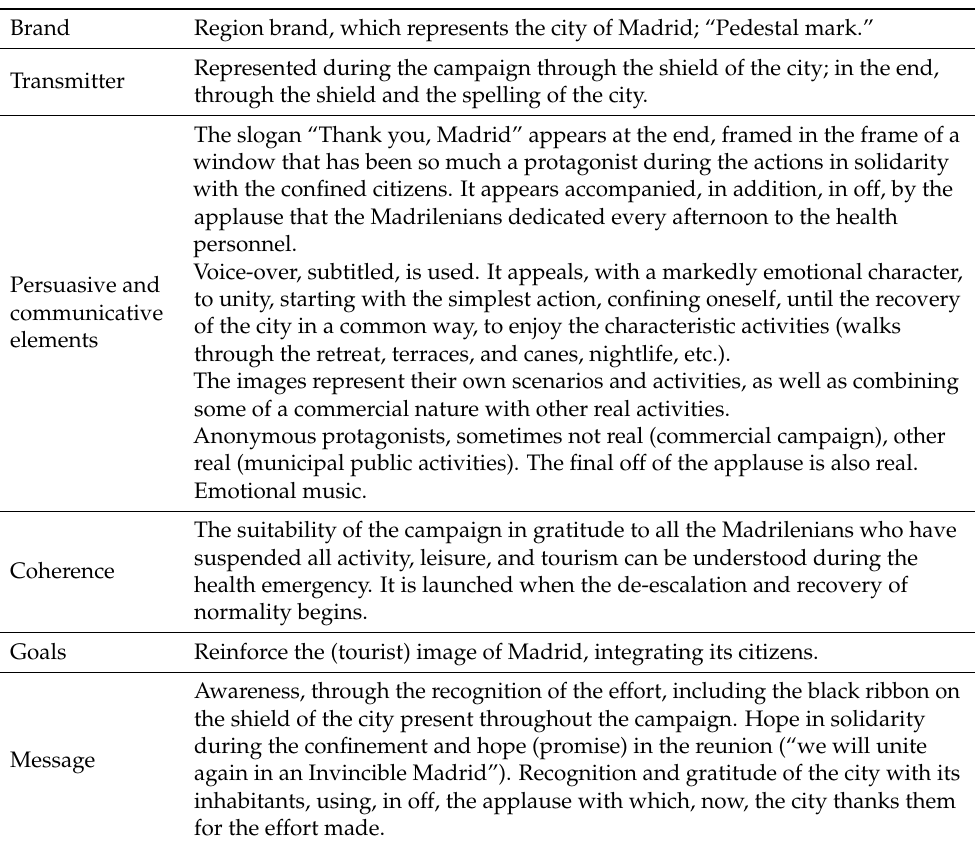
Table 5. Campaign analysis “Together we have never lost. Thank you,